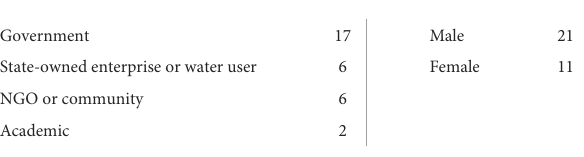
TABLE 2 Summary of